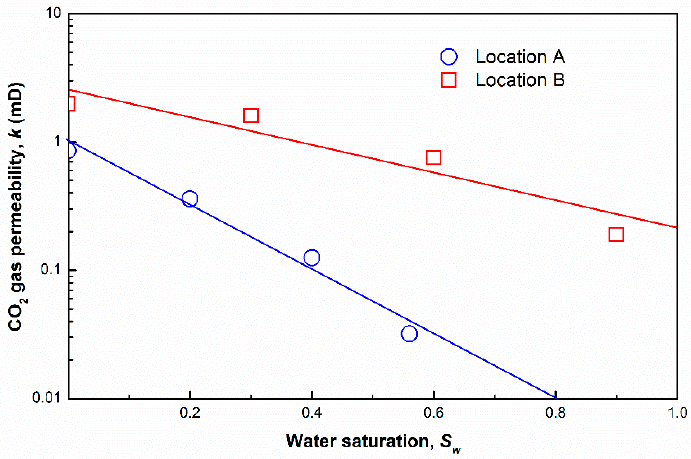
Figure 7. Carbon dioxide (CO 2 ) gas permeability versus water saturation ( S w ) at Locations A and B.